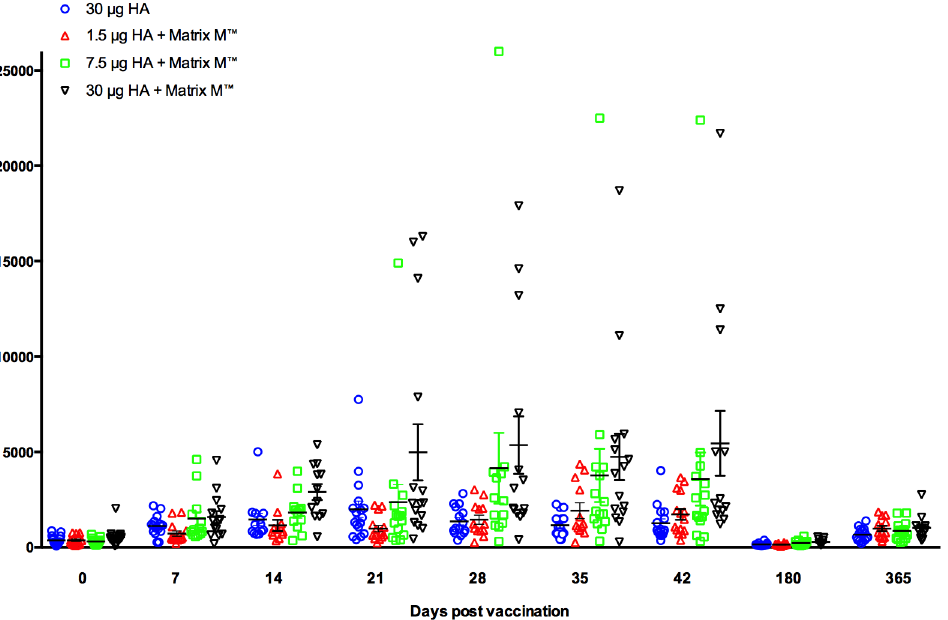
Fig 6. The H5N1-specific IgG response after vaccination. An ELISA was used to measure the NIBRG-14 influenza vaccine-specific serum IgG response before and after vaccination. Subjects were vaccinated with two doses (21 ± 1 days apart) of inactivated virosomal H5N1 vaccine alone (30 μ g HA, blue) or 1.5 (red), 7.5 (green) or 30 μ g HA (black) adjuvanted with Matrix-M (50 μ g). The bars represent the mean IgG titre ± standard error of the mean.